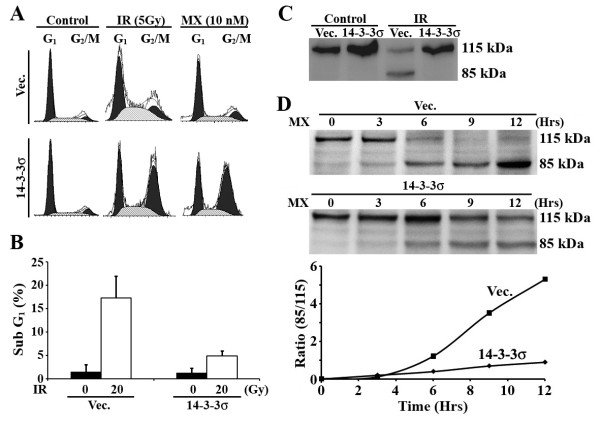
14-3-3σ over-expression increased drug-induced G2/M arrest and resistance to drug-induced apoptosis. A, Cell cycle distribution analysis. Vector- and 14-3-3σ-transfected stable MiaPaCa-2 cells were treated with 5 Gy γ-irradiation (IR), 10 nM mitoxantrone, or control without treatment followed by analysis of cell cycle distribution using FACS. B, Effect of 14-3-3σ radiation-induced apoptosis. Vector- and 14-3-3σ-transfected stable MiaPaCa-2 cells were treated with (filled bars) or without (white bars) γ-irradiation followed by analysis of cells at sub-G1 phase using FACS. C and D, Effect of 14-3-3σ on radiation- and drug-induced PARP cleavage. Vector- and 14-3-3σ-transfected stable MiaPaCa-2 cells were treated with 20 Gy γ-irradiation (C) or 10 μM mitoxantrone (D) for the times indicated followed by analysis of PARP cleavage using Western blot analysis. The graph in panel D shows the rate of production of the 85-kDa PARP fragments product (as a ratio of the 85-kDa fragment to the full-length 115-kDa protein).